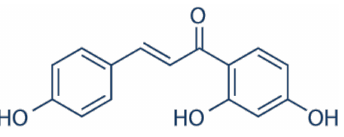
Figure 17. The chemical structure of